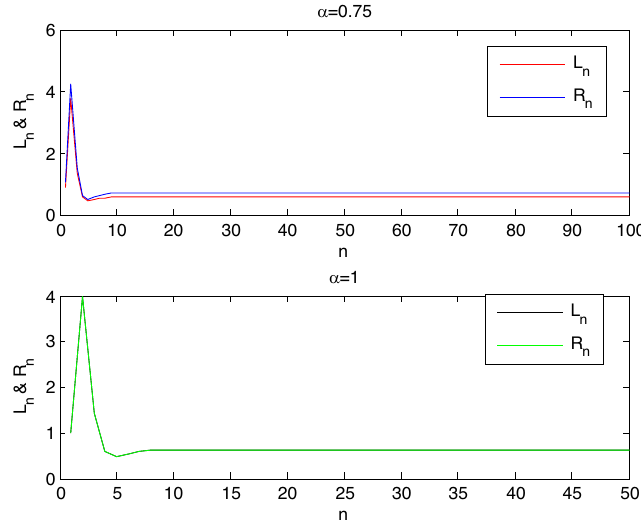
Figure 3: The solution of system ( 48 ) at = α 0.75 and = α 1